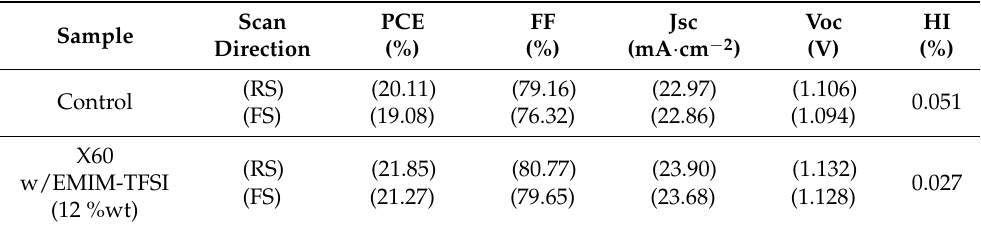
Figure 2. ( a ) J–V curves of the best performing control and EMIM-TFSI-doped (12 wt%) devices. ( b ) EQE spectra for the best performing devices. The integrated current density depicted on the right axis was calculated from the device’s spectral response and the AM1.5G photon flux spectrum. Integrated current density was estimated at 22.85 and 23.97 and mA cm − 2 for the control and EMIM-TFSI (12 wt%), respectively. Table 2. The photovoltaic parameters of the best performing devices under different scan directions and HI estimated